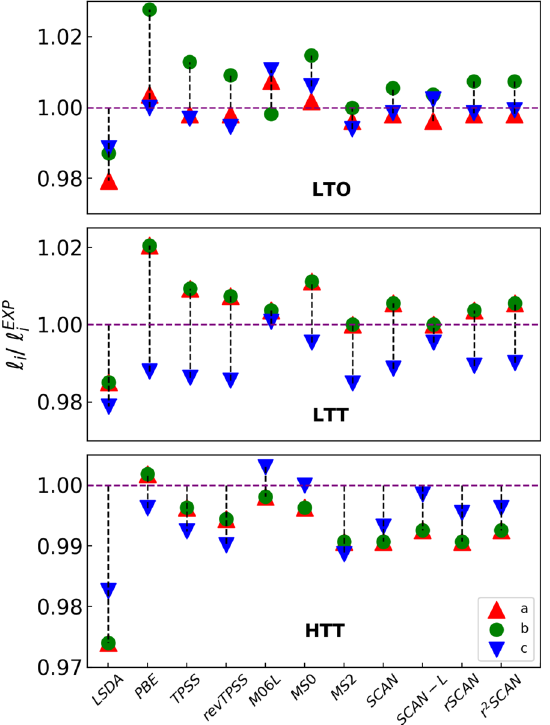
Fig. 3 Comparison of the theoretically obtained and experimental lattice constants a , b , c for the HTT, LTT, and LTO crystal structures using various density functional approximations for La 2 CuO 4 . The lattice constant values are divided by corresponding experimental values.